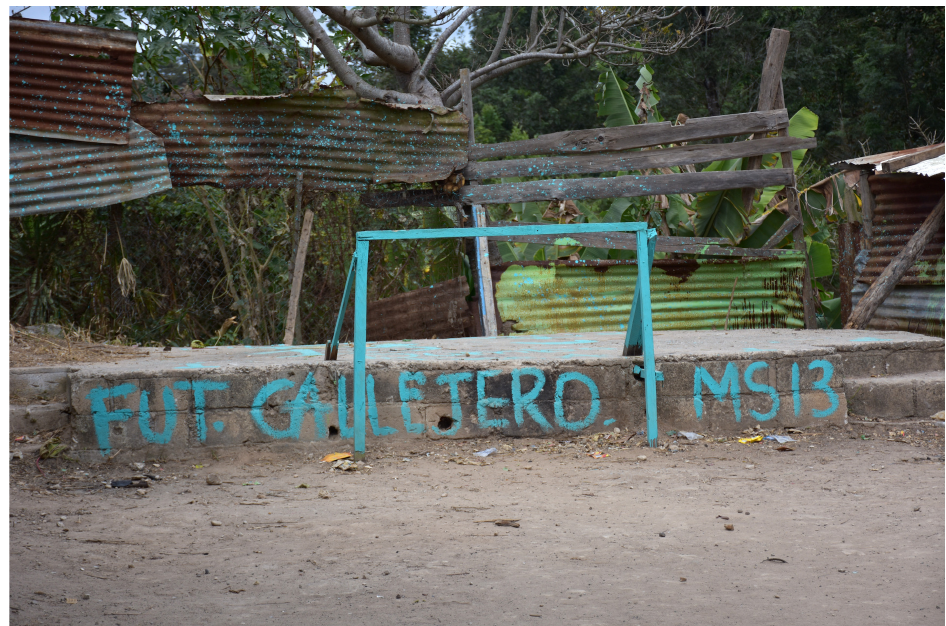
Figure 5. Soccer field in 5 de